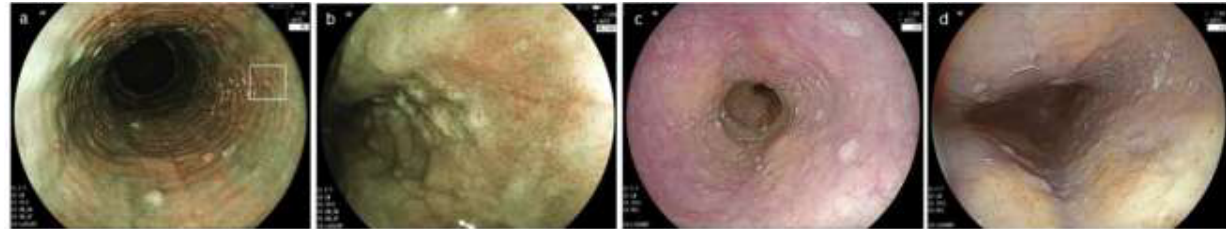
Figure 5. Endoscopic findings by IEE in EoE. ( a ). Beige color mucosa (BLI) ( b ). Magnified image of the area indicated by the white frame in Figure ( a ). Dot-like intrapapillary capillary loops are seen. Cyan submucosal vessels are invisible (BLI). ( c ). Yellowish mucosa (LCI, proximal esophagus). ( d ). Yellowish mucosa (LCI, middle esophagus). IEE, image enhanced endoscopy; EoE, eosinophilic esophagitis; BLI, blue laser imaging; LCI, linked color imaging.